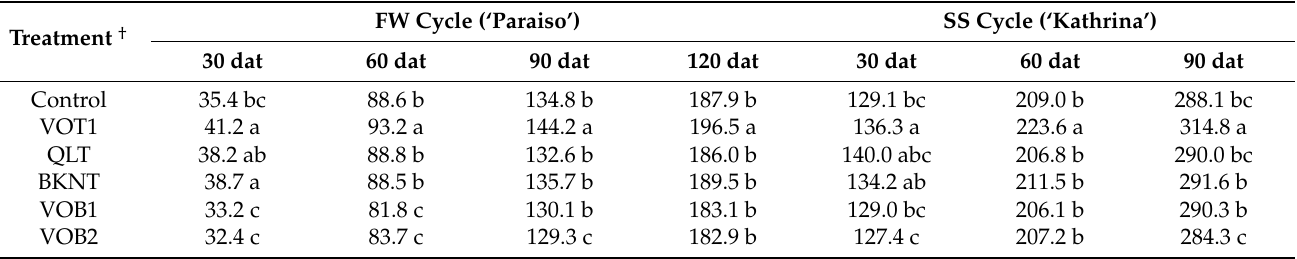
Table 7. Effect of treatments on height (cm) of cucumber plants during the FW and SS